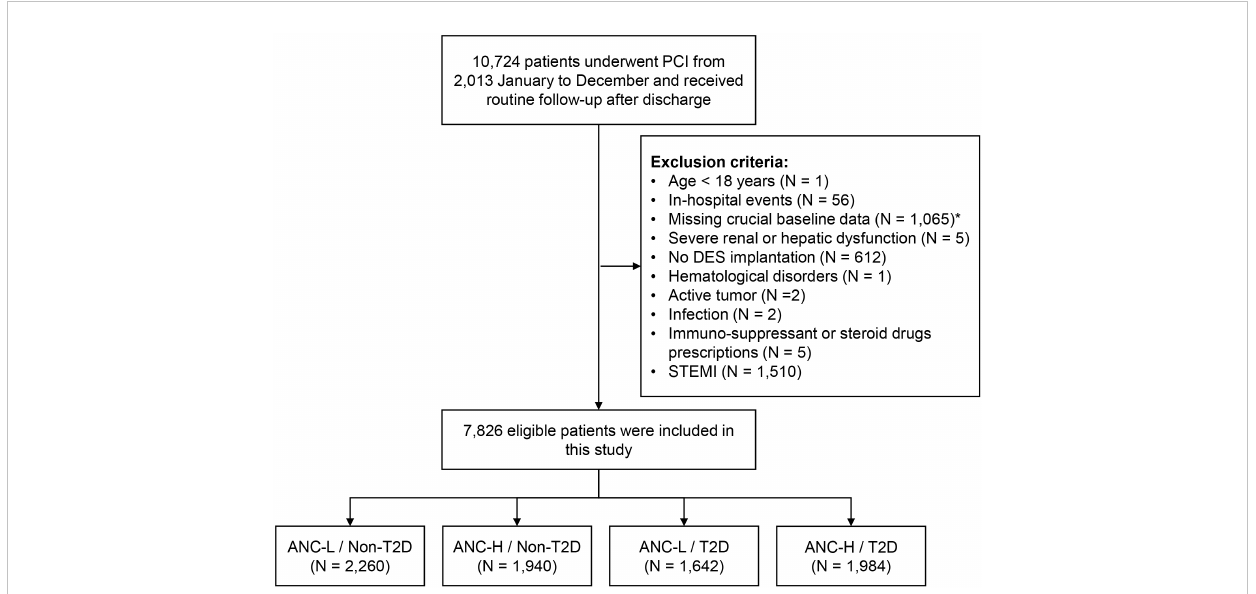
FIGURE 1 Study fl owchart. *A total of 708 patients with missing ANC and 409 patients with missing FBG or HbA1c levels were excluded. PCI, percutaneous coronary intervention; DES, drug-eluting stent; STEMI, ST-segment-elevation myocardial infarction; ANC, absolute neutrophil counts; T2D, type 2 diabetes; FBG, fasting blood glucose; HbA1c, glycosylated hemoglobin